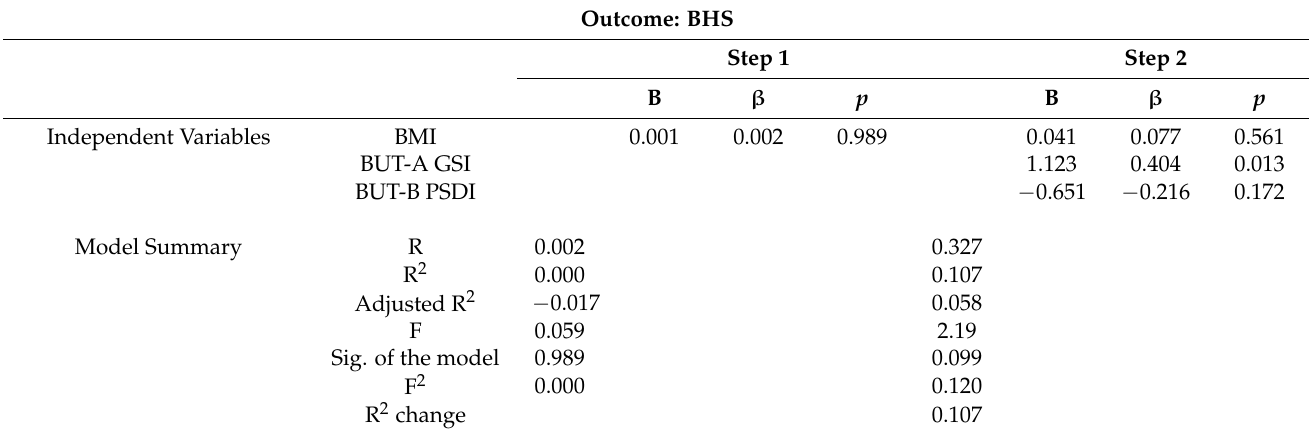
Table 8. Sixth hierarchical regression models including two steps, with BMI as predictor in first step; BMI, BUT-A GSI, and BUT-B PSDI as predictors of BDI II in second step. Outcome: BHS Step 1 Step 2 B β p B β p Independent Variables BMI 0.001 0.002 0.989 0.561 1.123 − 0.651 − 0.216